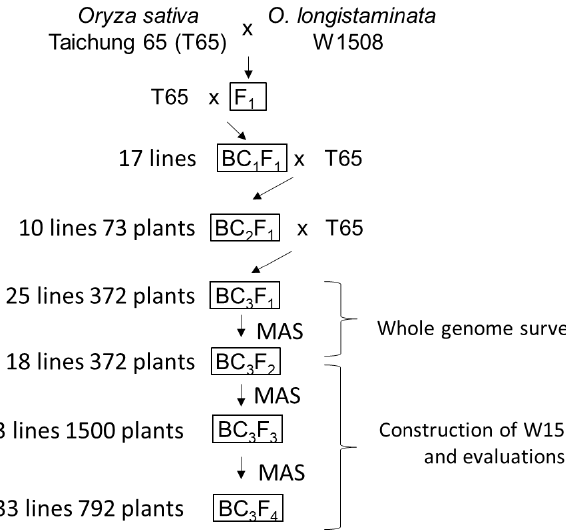
Figure 2. Breeding scheme of genetic materials used in this study. MAS represents marker-assisted selection.